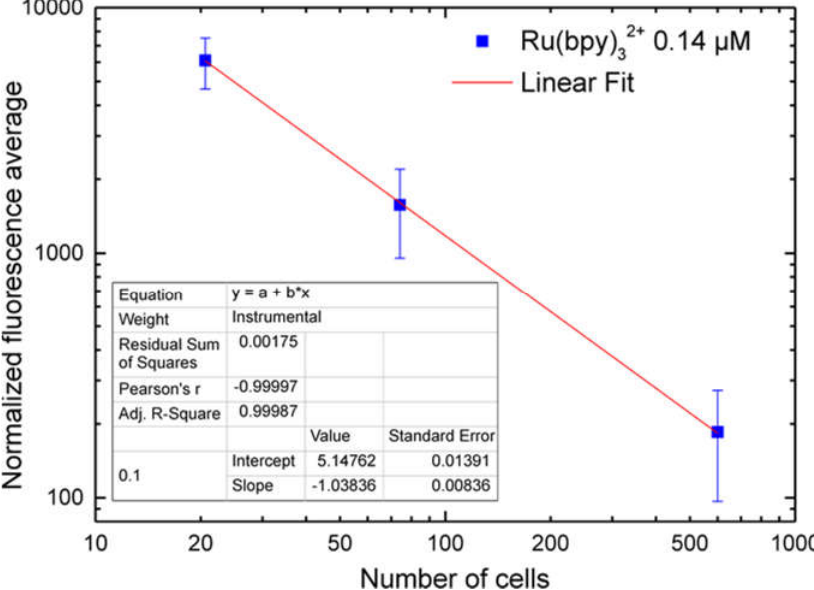
Figure 10. LoVos fluorescence as a function of their number for 0.14 µ M Ru(bpy) 32+ labeling across cell generations (600 cells correspond to 5 days recovery time). Fluorescence was acquired with a 488 nm light source and collected at 620–630 nm.